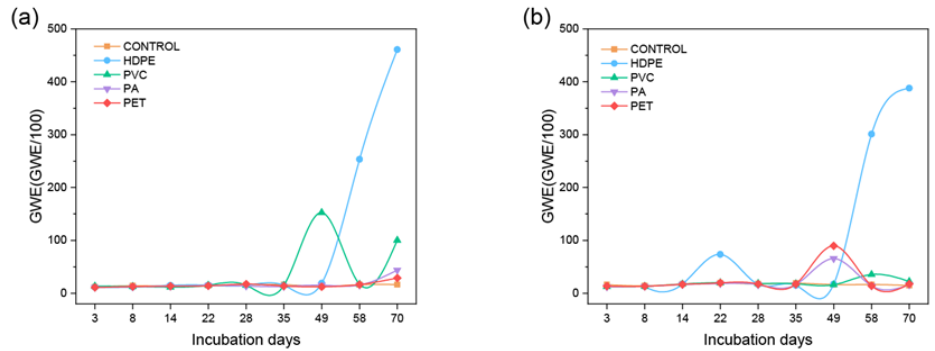
Figure 5. GWE in freshwater ecosystems ( a ) Poyang Lake ( b ) paddy soil.